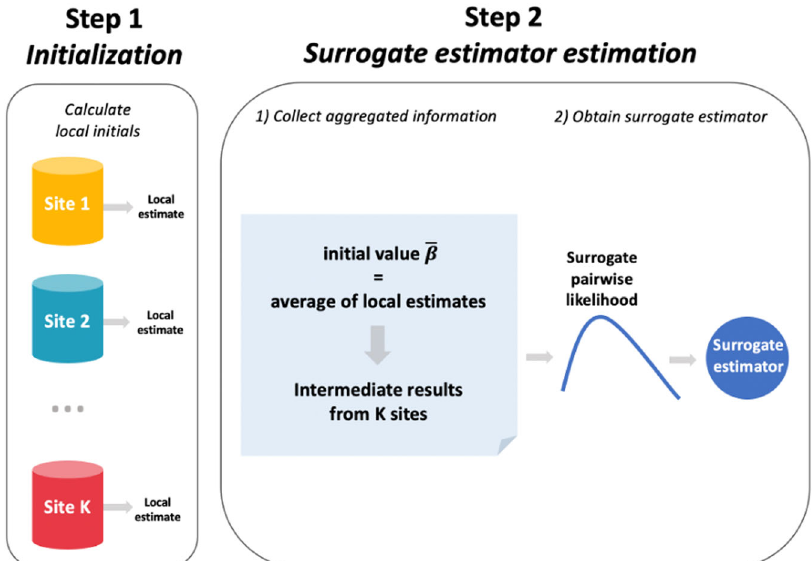
Fig. 5 Illustration of the proposed method. Step I: Using data from each local site to estimate initial estimates and broadcast the values to calculate the weighted initial value β . Step II: With the initial value β , calculating the intermediate terms at each site and then transfer the results back to the local site. With the intermediate results and initial value β to construct the surrogate pairwise log-likelihood function in the local site. Maximizing the surrogate pairwise likelihood to obtain the surrogate